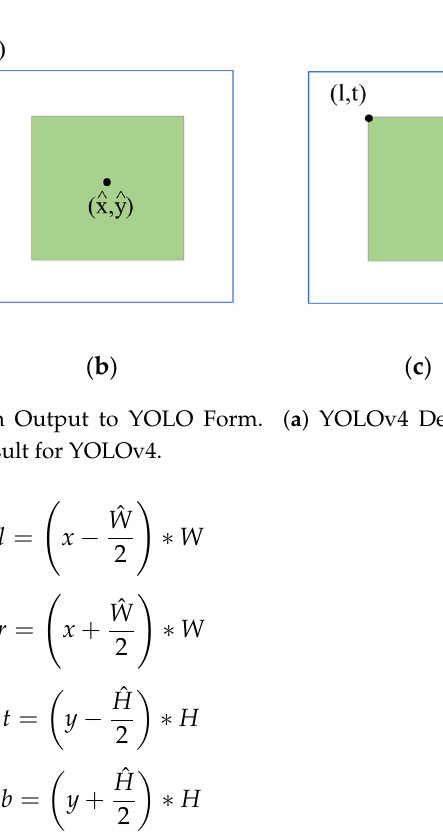
Figure 8. Detection result of the YOLOv4 traditional model (Mid-length dress: 95% (left_x: 42 top_y: 13 width: 142 height: 196)).